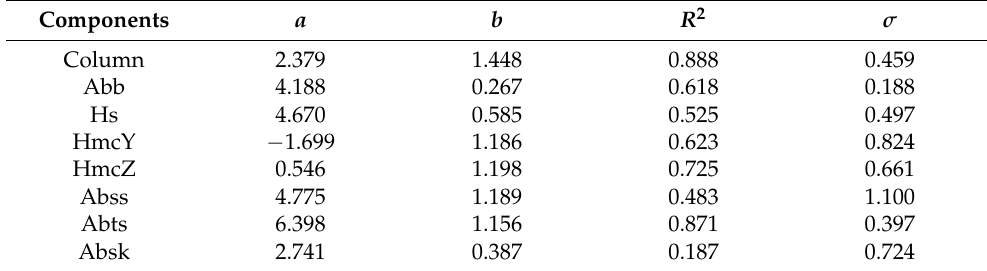
Table 2. Probabilistic seismic demand parameters.